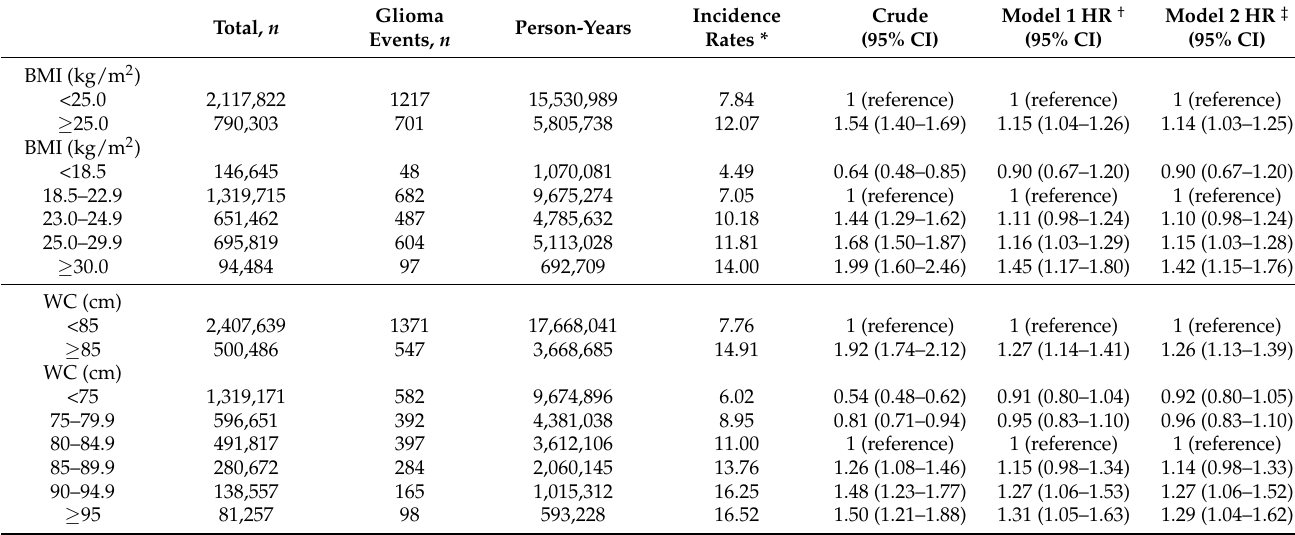
BMI, body mass index; CI, confidence interval; HR, hazard ratio; n , number; WC, waist circumference; * per 100,000 person-years; † Model 1: adjusted for age and sex; ‡ Model 2: adjusted for model 1 plus smoking status, alcohol consumption, exercise level, and the presence of diabetes mellitus. Table 5. Incidence rates and risks of glioma development according to BMI and WC in females. Incidence Crude Glioma Person-Years Total, n Rates * (95% Events, n